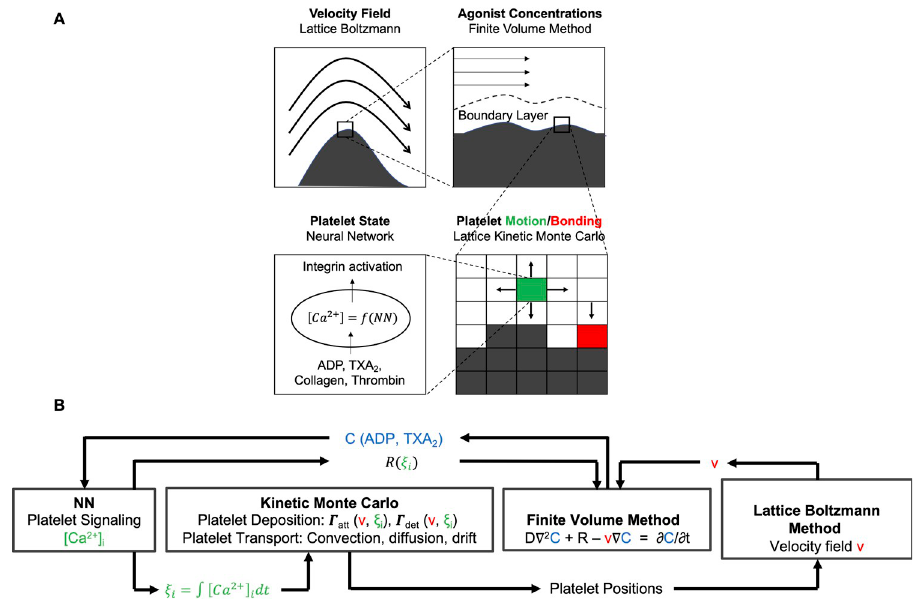
Fig 1. Multiscale model for thrombus growth under flow. The multiscale simulation of thrombus growth under flow required simultaneous solutions of the instantaneous velocity field over a complex and evolving platelet boundary by LB, concentration fields of ADP and TXA 2 by FVM, individual intracellular platelet state ([Ca] i ) and release reactions (R) for ADP and TXA 2 by NN, and all platelet positions and adhesion/detachment by LKMC.